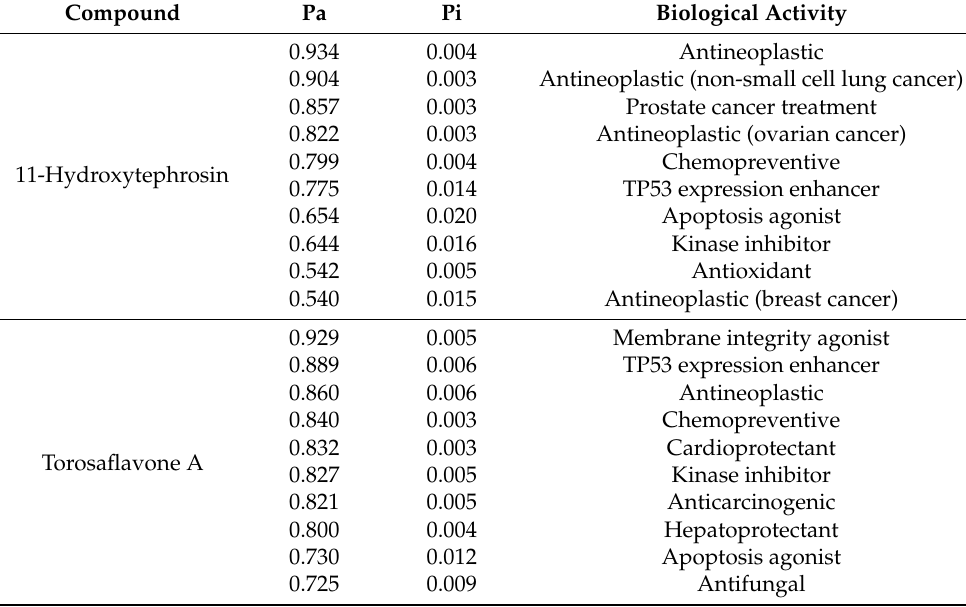
Table 3. The top 10 relevant biological properties of the elucidated